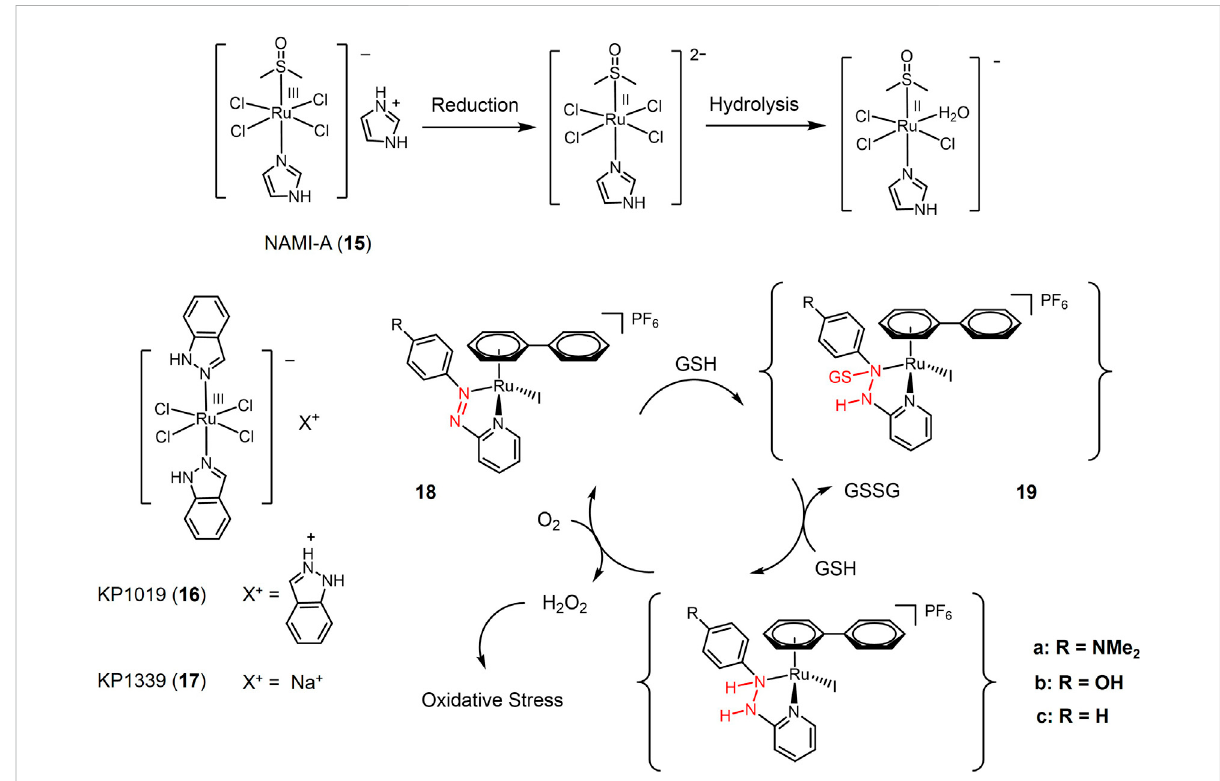
FIGURE 3 Redox-responsive Ru(III) complexes NAMI-A ( 15 ), KP1019 ( 16 ) KP1339 ( 17 ) that have entered clinical trials, and Ru(II) complexes with redox- active azole-ligand ( 18a-c